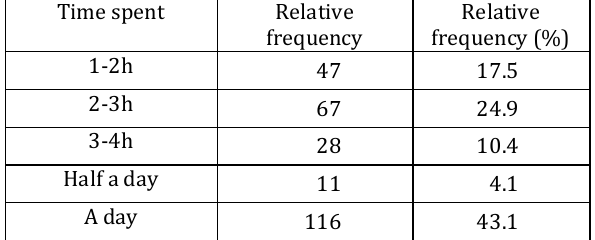
Table 6. Time spent inside the forest park